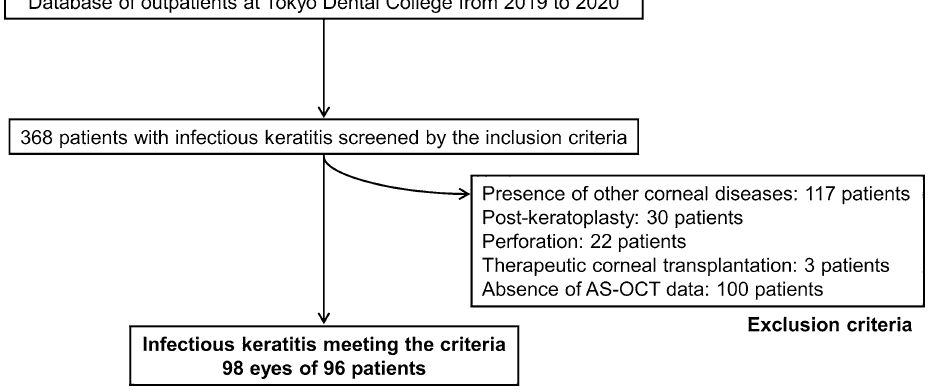
Figure 1. Patient selection flowchart. AS-OCT anterior segment optical coherence